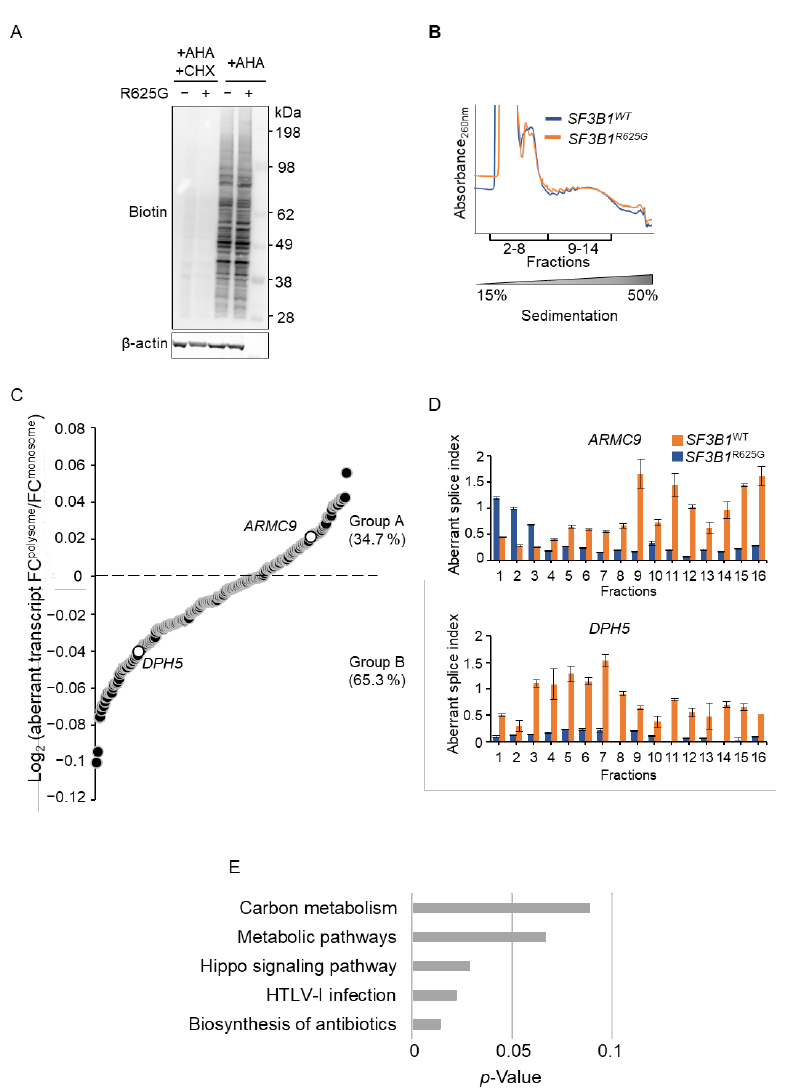
Figure 1. Impact of SF3B1 R625G on nascent protein synthesis and translation fate of the SF3B1 R625G - induced splicing transcripts. ( A ) Nascent protein synthesis in SF3B1 WT and SF3B1 R625G Mel202 cells